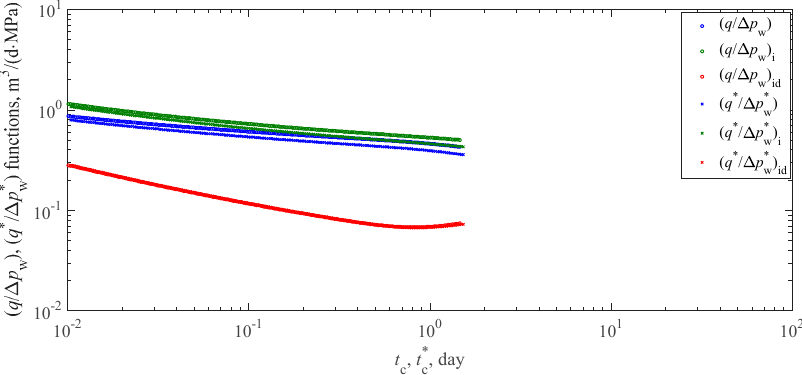
Figure 13. Normalized rate functions and modified normalized rate functions for CRP case of q = 20 m 3 /d.